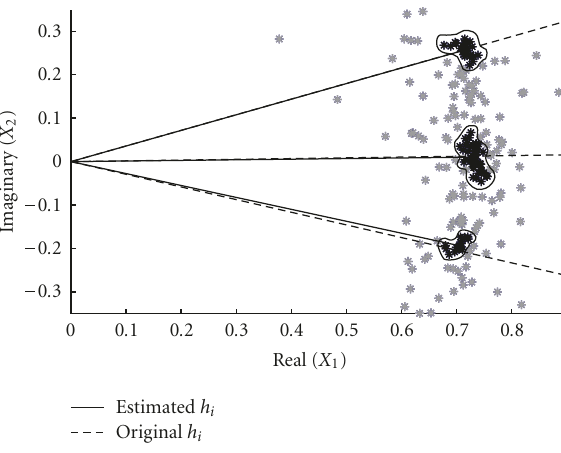
Figure 4: Estimation of mixing vectors, f = 1164